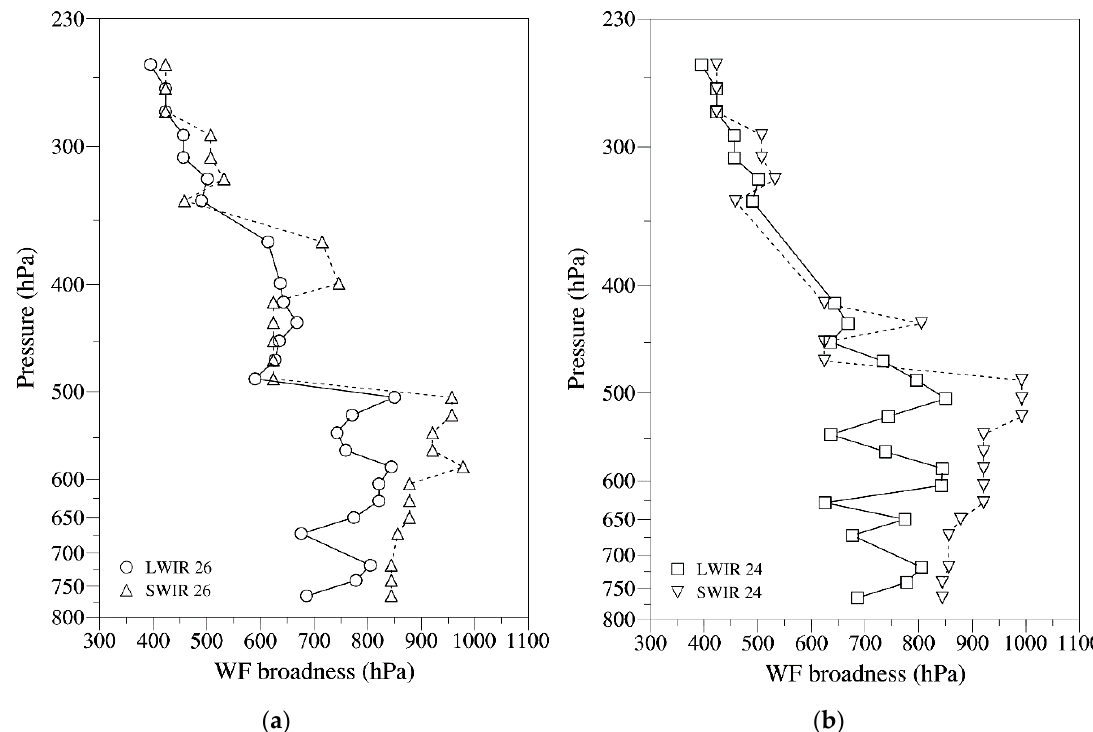
Figure 7. Vertical distribution of WF broadness for ( a ) modified method’s 26 pairs and ( b ) original